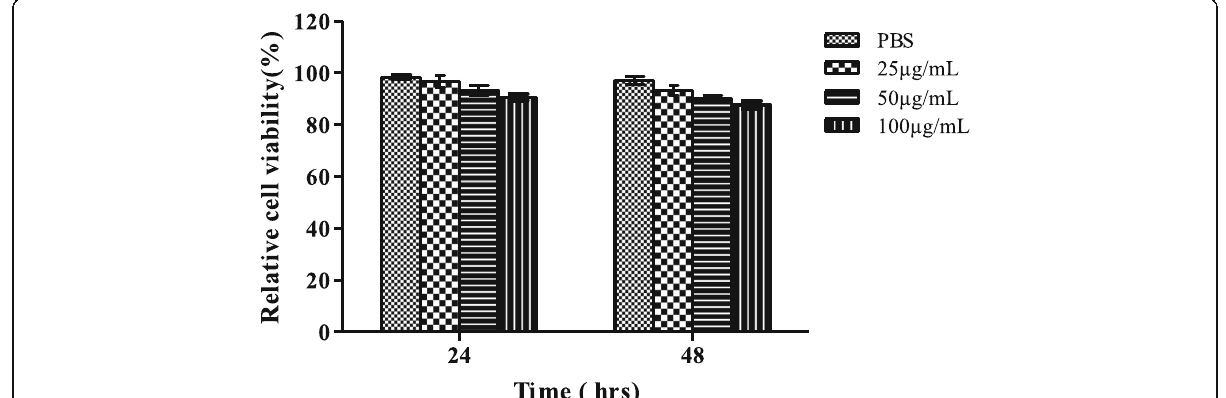
Fig. 6 Cytotoxicity of zerumbone against Vero cell line using MTT assay. The data are representative of three independent experiments and the results are expressed in mean ±